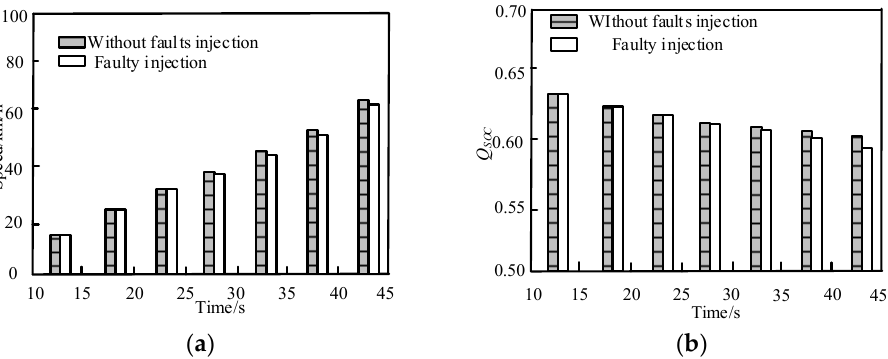
Figure 8. Variation in driving speed and the remaining hydraulic energy of the hydraulic accumulator in the experimental vehicle model with and without faults. ( a ) Speed changes; ( b ) change in the remaining hydraulic energy of the hydraulic accumulator.